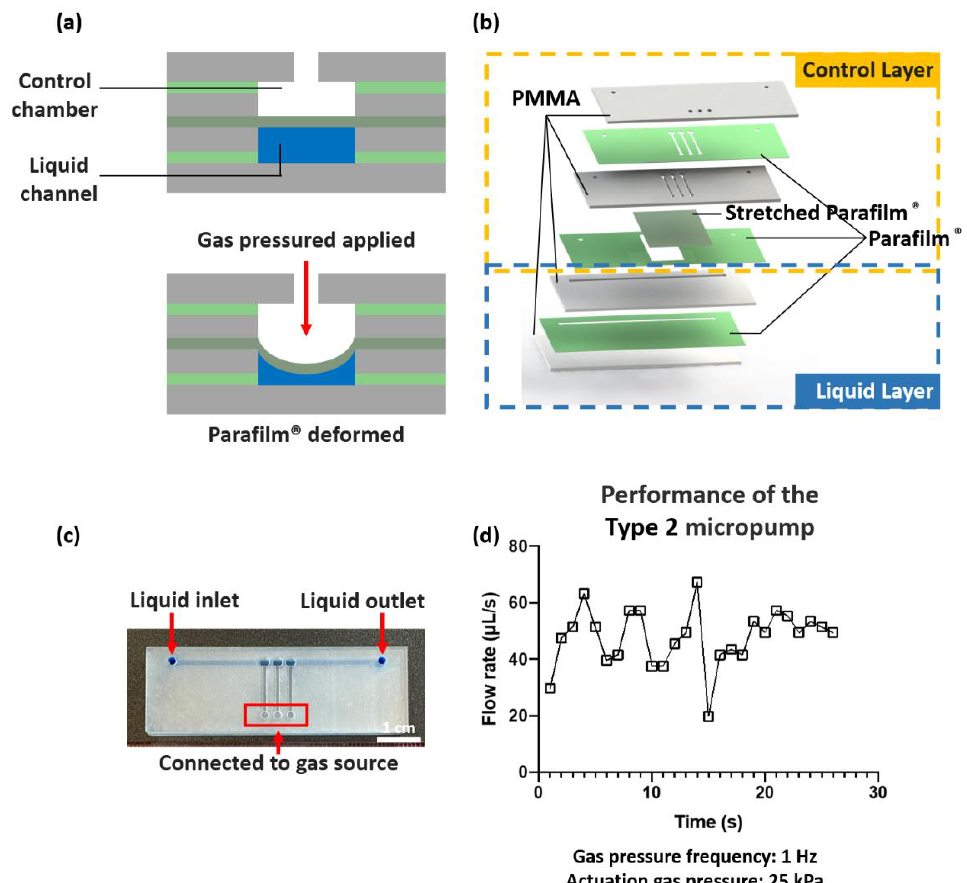
Figure 5. Fabrication and characterization of the normally open microvalve and micropump. ( a ) Operation design of the microvalve. When gas pressure was applied to the control chamber, the Parafilm ® was deformed to actuate liquid flow. ( b ) The 3D architecture of the fabricated micropump with multiple microvalves. Parafilm ® was utilized to work as both the bonding agent and functional membrane. ( c ) Photograph and schematic showing the fabricated micropump. The control chamber is on the top and the liquid channel is at the bottom. Scale bar = 1 cm. ( d ) Effect of actuation pressure and frequency on actuating flow rate.